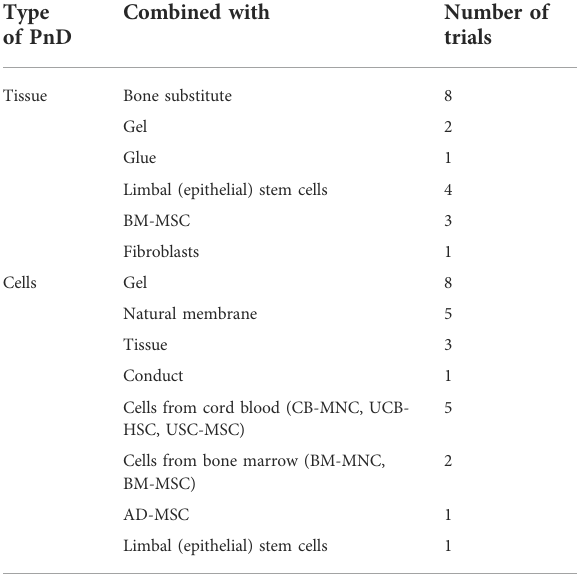
TABLE 2 Number of clinical trials with combined cells or